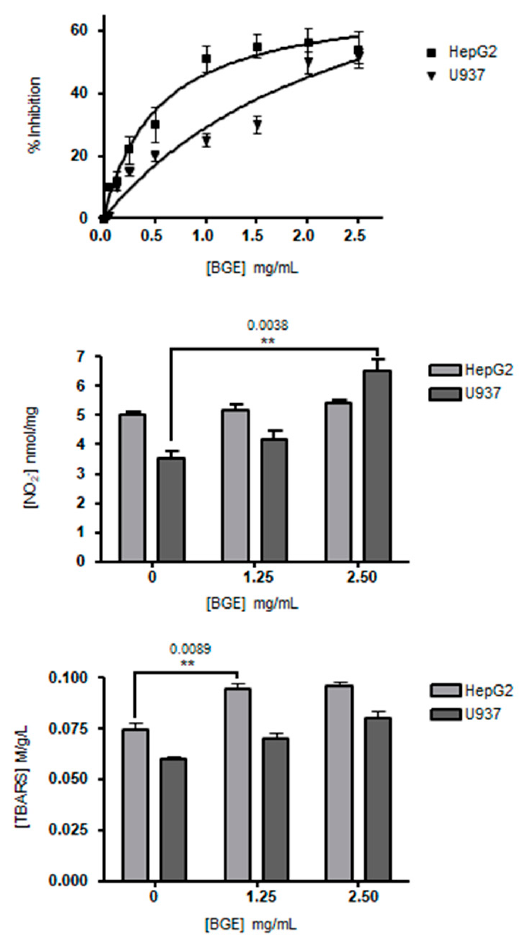
Figure 2. Effects of black garlic extract on cell viability and oxidative stress. In the upper panel, the inhibitory effects of different concentrations of BGE (0–2.5 mg/mL) on HepG2 and U937 cells were evaluated by MTT assay and expressed as percentage of inhibition compared to control (HepG2 and U937 cells without BGE treatment). After 24 h of BGE treatment, the IC 50 were 0.8 mg/mL and 2 mg/mL on HepG2 and U937, respectively. In the central panel, the effect of BGE on free nitric oxide (NO) level evaluated in the intercellular medium of BGE-treated HepG2 and U937 ( p = 0.0038) cells was reported. In the bottom panel, lipid peroxidation in cytosol was evaluated by TBARS assay in BGE-treated HepG2 ( p = 0.0089) and U937 cells. Data were mean ± SD ( n = 3). The effects on cellular oxidative stress upon BGE treatments (1.25 and 2.50 mg/mL) were determined by evaluating free nitric oxide (NO) concentration as nitrites in cell culture medium and lipid peroxidation as TBARS in cytosol of both HepG2 and U937 cells (Figure 2, central and bottom panels). After 24 h of 2.50 mg/mL BGE treatment, U937 cells showed a significant increase ( p = 0.0038) of free NO release of about 49% compared to the untreated U937, while there was no effect on HepG2 cells compared to the untreated HepG2 (Figure 2, central panel). In rats, BGE also demonstrated vasodilating effect in tail artery segments by NO induction and increased the NO release in aorta segments [39]. NO generated by the NO synthase (NOS) enzymes plays the role of intercellular messenger that regulates different key functions, such as gene expression, differentiation, cell cycle, and apoptosis [40–42]. The inhibition effect of BGE on U937 cells could be due to its ability of activating the production of NO by NOS enzymes and, indirectly, of scavenging superoxide anion radicals (O 2 − ) that induce the transformation of NO into peroxynitrite (ONOO − ), which consequently cannot play the function as a second